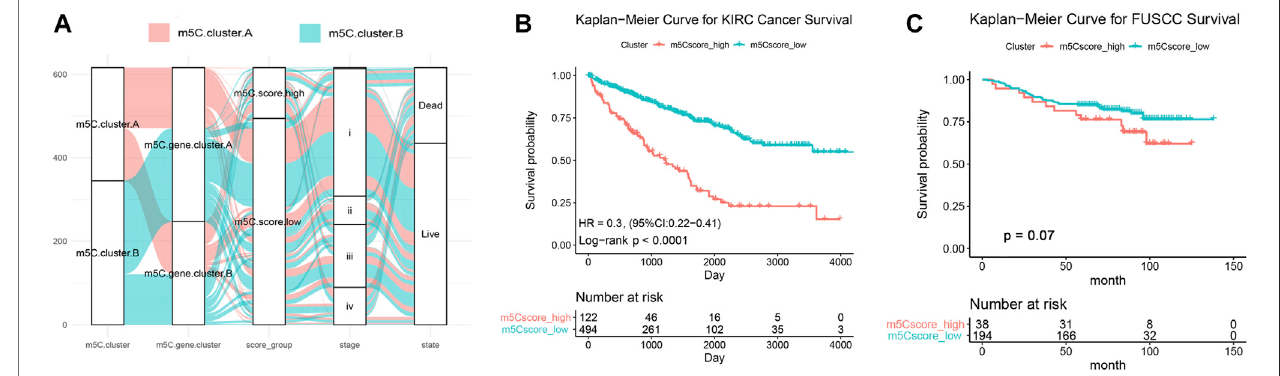
FIGURE 6 | Generation and validation of the m 5 C score model. (A) Sanky diagram of the various clusters. (B) Overall survival curve of ccRCC patients from TCGA cohort strati fi ed by m 5 C score. (C) Overall survival curve of 233 ccRCC patients from FUSCC cohort strati fi ed by m 5 C score.